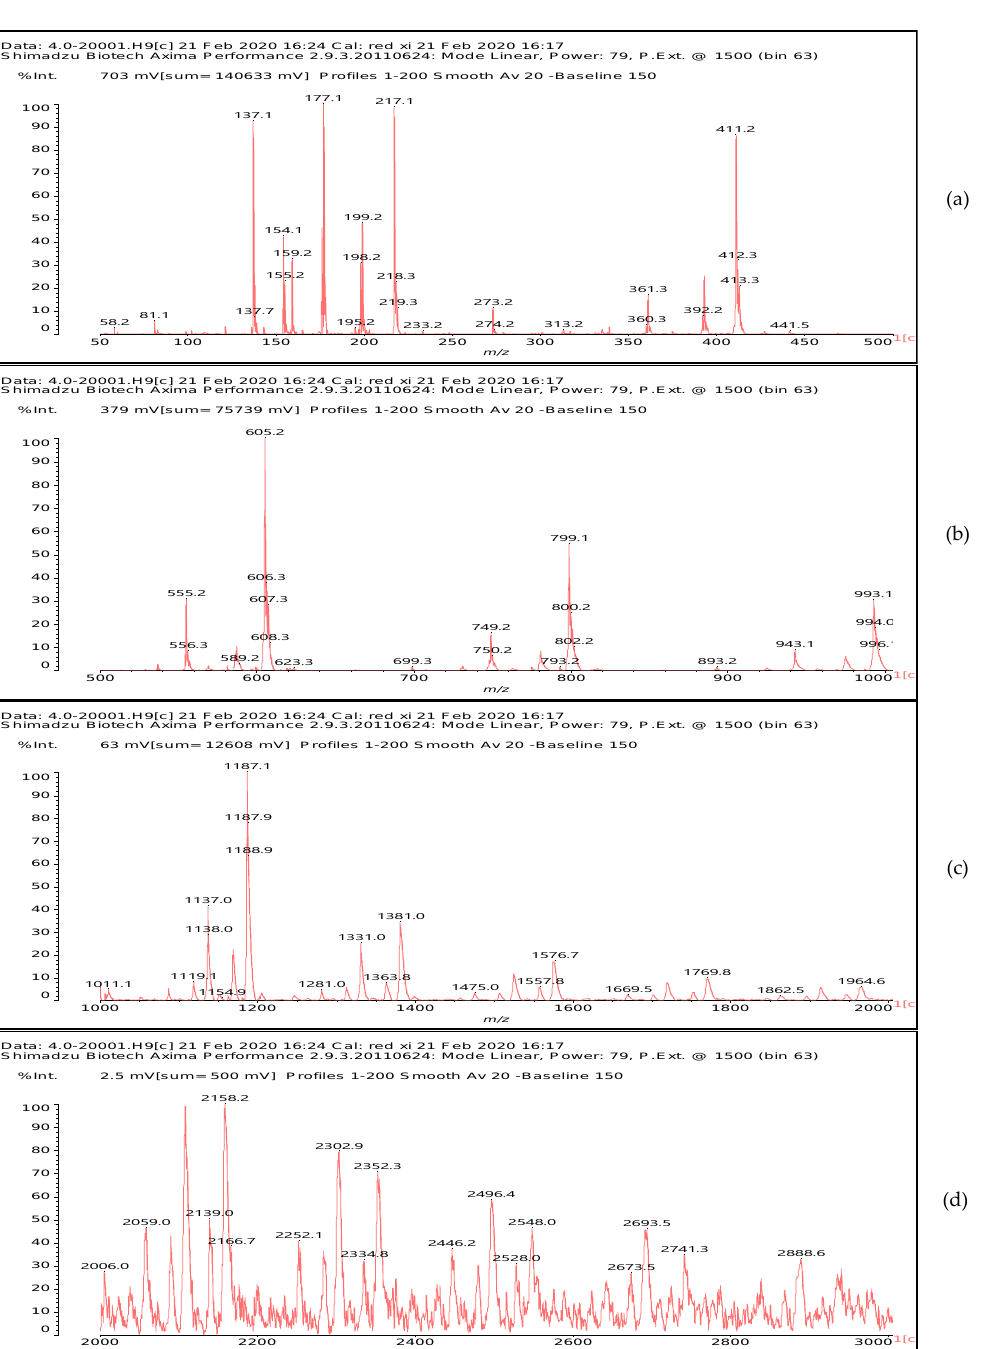
Figure 8. MALDI ToF spectrum of the furanic-glyoxal foams : ( a ) 50Da-500Da range. ( b ) 500Da-1000Da range. ( c ) 1000Da-2000Da range. ( d ) 2000Da-3000Da range. An alternative interpretation may also be a possibility for the peak at 232 Da, which is due to a linear oligomerization of the glyoxal by aldol condensation [25]: